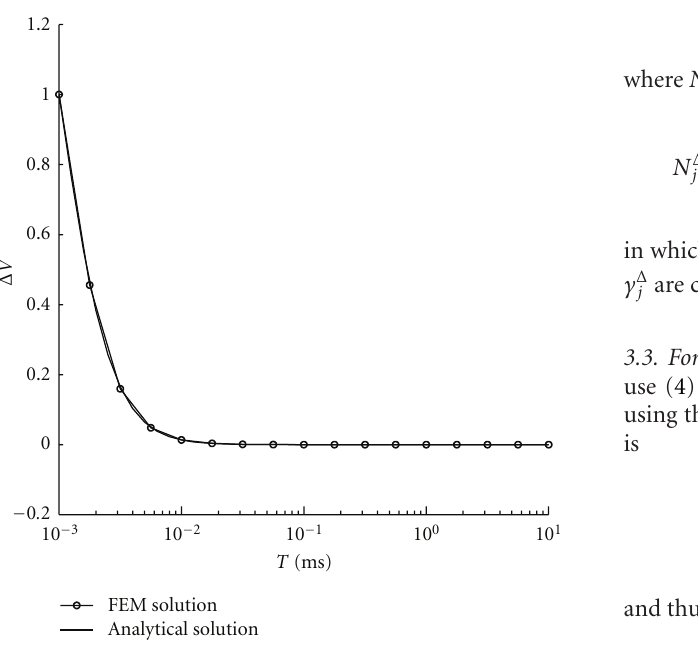
Figure 2: Comparison between FEM results with analytical results for the normalized vertical EMF on a 3-layer earth.